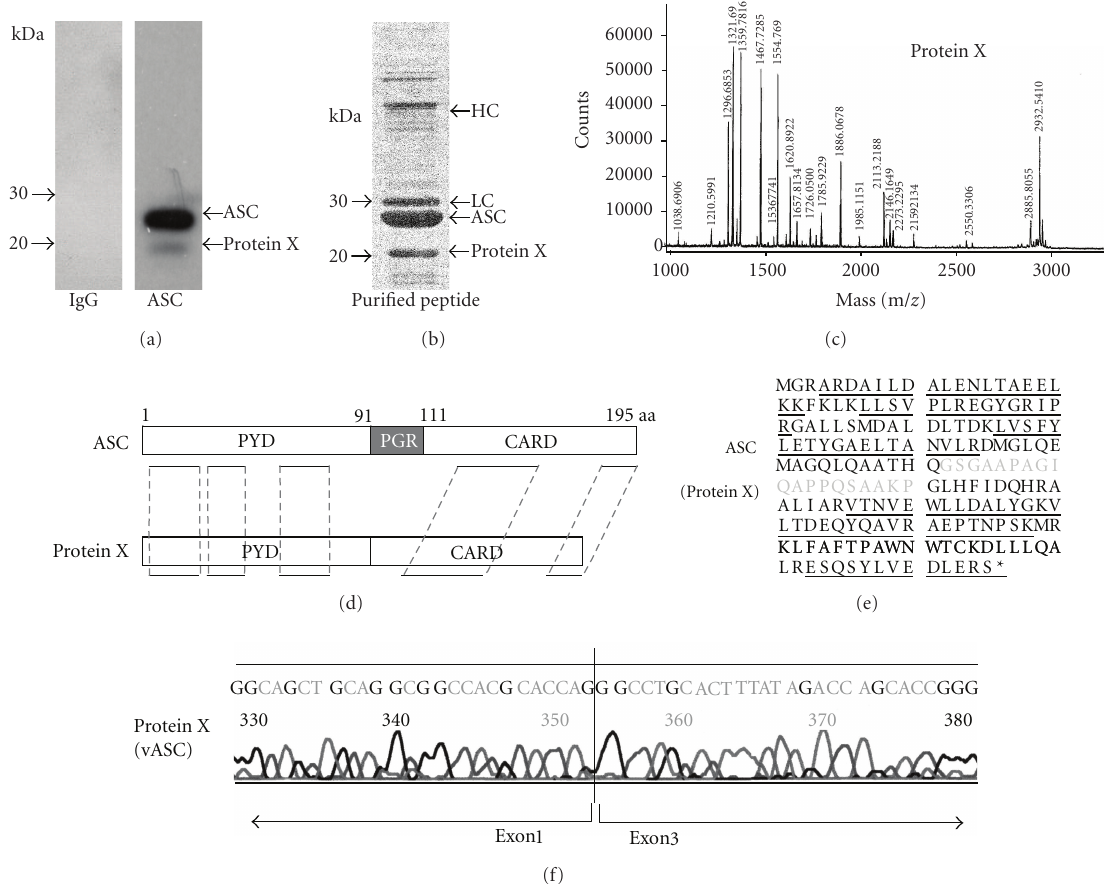
Figure 1: Analysis of protein X by mass spectrometry . (a) HL-60 cells were subjected to SDS-PAGE and western blot analysis using antihuman ASC antibody. In addition to full length ASC (fASC), an additional polypeptide of 20 kDa (Protein X) was detected. (b) Proteins that were a ffi nity-purified using anti-ASC antibody were stained with Coomassie Blue. HC: Ig heavy chain, LC: Ig light chain. (c) Mass spectrum of digested protein X is shown. (d) Structures of ASC and Protein X. Homologous regions are underlined. aa: amino acid. (e) Amino acid sequence of fASC from a database (GenBank Accession no. NP 037390) and Protein X is displayed. Homologous sequences are underlined. The amino acid sequence written in light characters was not detected in Protein X. (f) Sequence of ASC cDNA extracted from HL-60 cells as Protein X is shown.